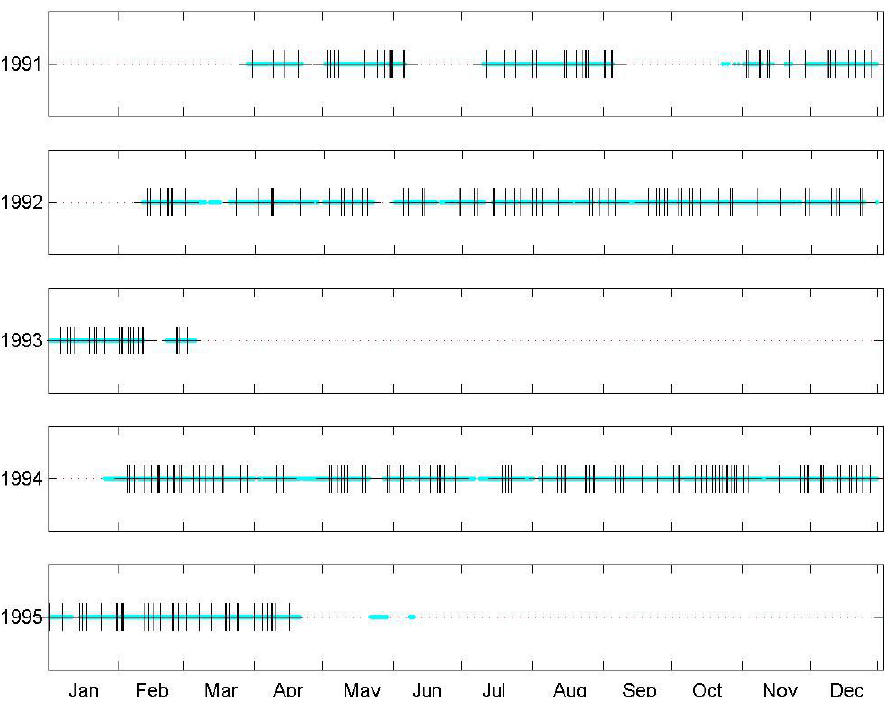
Fig. 3. Incidence of freak wave occurrences in wave data recorded in the Campos Basin of the Southern Atlantic Ocean, which is located in the northeast coast of Rio de Janeiro, Brazil.